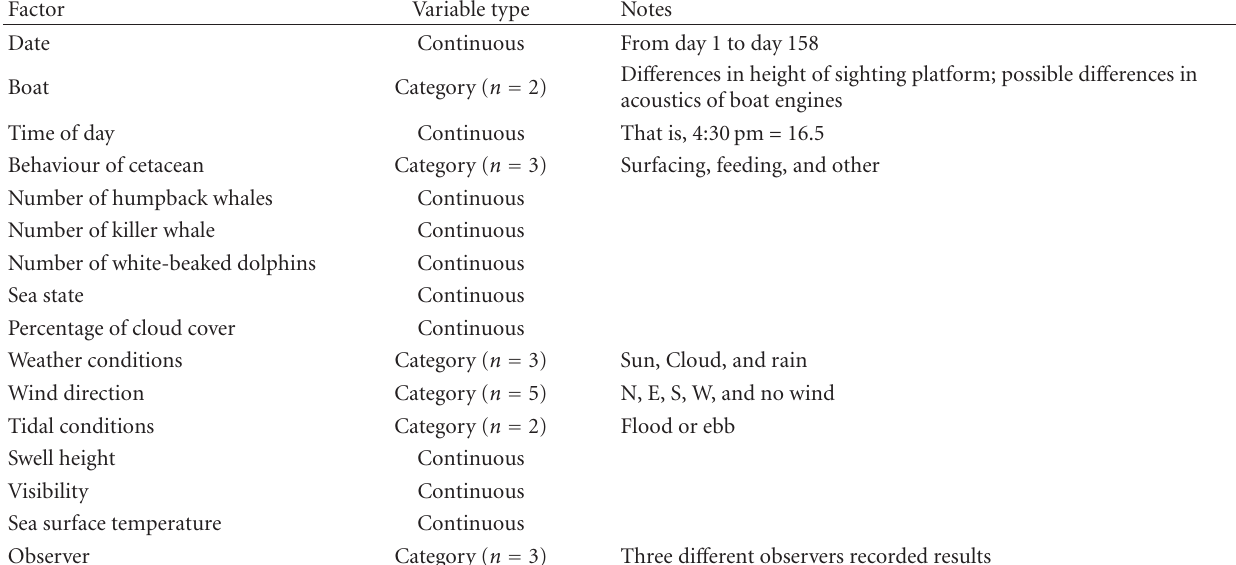
Table 1: Explanatory factors initially included in the linear model. Use of continuous and discrete (category) variables follows suggestions of [14], where category variables are categorised in as few as possible meaningful categories, and ordinal variables are assumed to be continuous. Logistic variables are categorised as discrete with n = 2 levels.